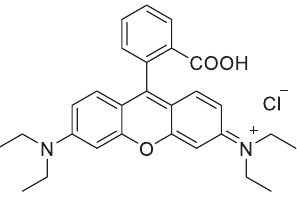
Figure 3: Chemical structure of rhodamine